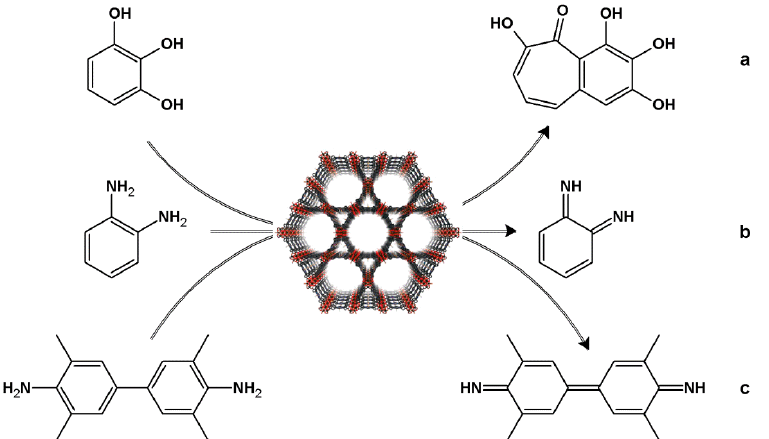
Figure 10. PCN-222(Fe)-catalyzed oxidations of ( a ) THB to purpurogallin; ( b ) OPD to o -quinonediimine; and ( c ) TMB to the respective diimine (adapted from [127] with permission. Copyright © 2012 WILEY-VCH Verlag GmbH & Co. KGaA,